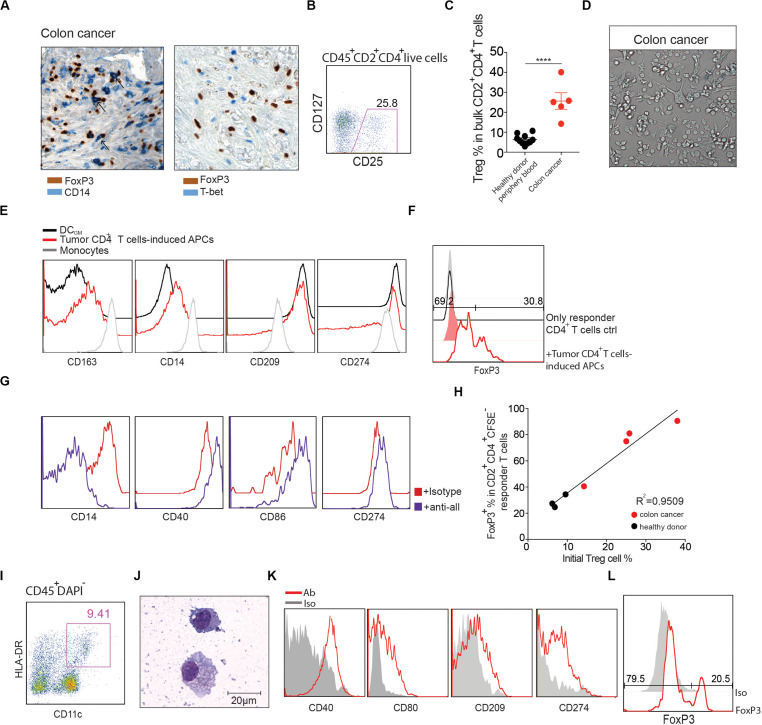
CRC CD4+ T cells induce DCReg formation. (A) Left: representative human colon cancer tissue stained with antibodies against FoxP3 (brown) and CD14 (blue). Black arrows represent potential monocyte-Treg interactions. Right: representative human colon cancer tissue stained with antibodies against FoxP3 (brown) and T-bet (blue). Magnification 400×. (B) Representative flow cytometry analysis of CD25+CD127low Tregs in CD45+CD2+ CD4+ T cells from colon cancer sample. (C) Comparison of the CD25+CD127low Treg percentages from healthy donor peripheral blood and colon cancer samples. Mean ± SEM. ****P < 0.0001, unpaired T test. (D,E) Lin–CD45+CD2+CD4+ T cells were purified from human CRC and co-cultured with peripheral blood CD14+ monocytes at a 1:10 ratio in the presence of anti-CD3 mAb for 4 days. (D) Images were captured with a bright-field DIC microscope on day 4. Original magnification 200×. (E) Flow cytometry analysis of the resultant antigen presenting cells (HLA-DR+CD2–) (red line) compared to monocytes cultured alone (gray line) or with GM-CSF and IL-4 (black line). (F) CD11c+HLA–DR+CD2– cells were purified via FACS and stimulated for 16 h with LPS. Cells were washed extensively and cultured with CFSE-labeled allogeneic naïve CD4+ T cells in a MLR. The percentage of FoxP3+ cells in CD2+CD4+CFSE– cells was determined 6 days later (red line). Naïve CD4+ T cells cultured alone (black line) are shown as controls. Shaded histograms represent isotype controls. Data are representative of 3 independent experiments. (G) In the presence of anti-CD3 mAb, CD14+ monocytes were cultured with bulk CD45+CD2+CD4+ T cells sorted from CRC, in the presence of a mixture of anti-CTLA-4 (5 μg/ml), anti-IL-10 (2 μg/ml), anti-TGFβ (2 μg/ml), or isotype control antibody (5 μg/ml). At day 4, cells in culture were analyzed by flow cytometry for the indicated surface markers. (H) CD14+ monocytes were cultured with bulk CD45+CD2+CD4+ T cells sorted from CRC (red) or healthy donor peripheral blood (black). CD25+CD127low Treg percentages were analyzed before coculture. The graph shows the correlation between the percentage of Tregs in CD2+CD4+ T cells prior to their initial culture with monocytes (X axis) and the percentage of CFSE–FoxP3+ T cells among the responder CD4+ T cells cultured with the DCs generated in the initial culture (Y axis). Linear regression was determined by prism. R2 = 0.9509. P = 0.0002. (I) Representative flow cytometry analysis of human CRC DCs. DAPI–CD45+ cells were further gated with CD11c, HLA-DR. (J) Cytospin of freshly FACS-sorted CD11c+HLA-DR+ DCs with Grunwald-Giemsa staining from CRC. Scale bar as indicated. (K) Flow cytometry analysis of CD40, CD80, CD86 and CD274 expression on gated CD11c+HLA-DR+ DCs. Red line: Ab staining. Shaded histograms represent isotype controls. (L) CD45+CD11c+HLA–DR+ DCs from CRC were sorted by FACS and cultured with CFSE-labeled naïve allogeneic CD4+ T cells. The percentage of FoxP3+ cells in CD2+CD4+CFSE– cells was determined 6 days later.